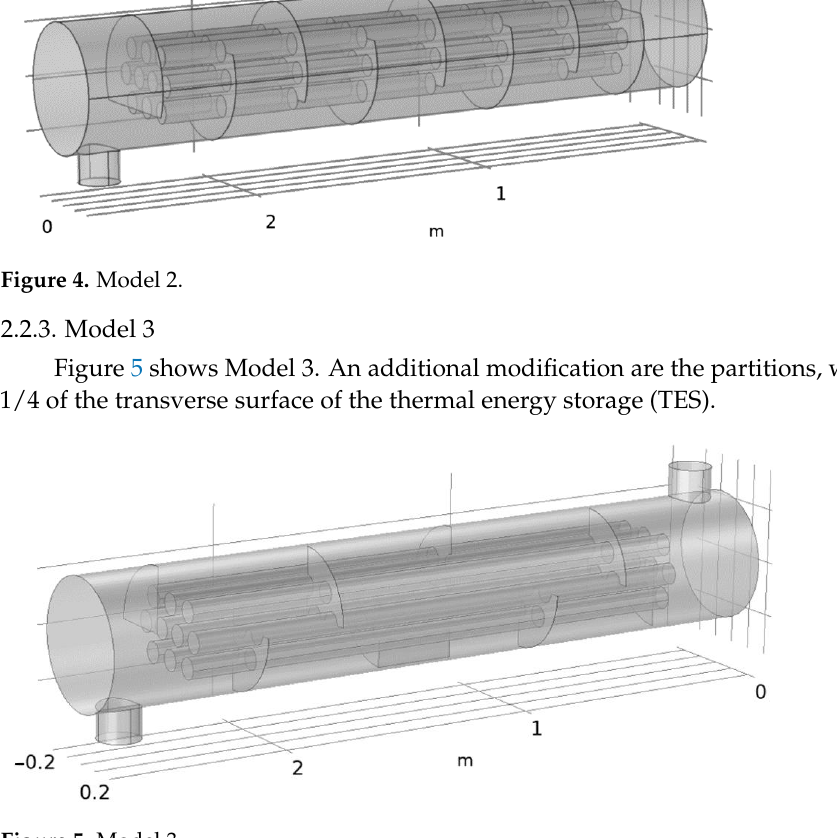
Figure 3. Model 1.